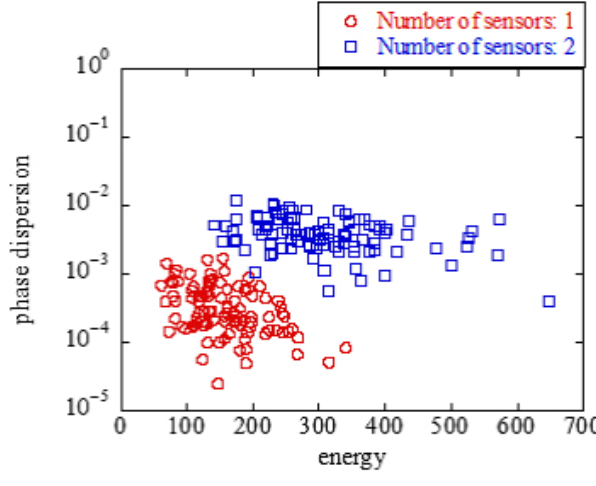
Figure 10. w/ antenna selection.